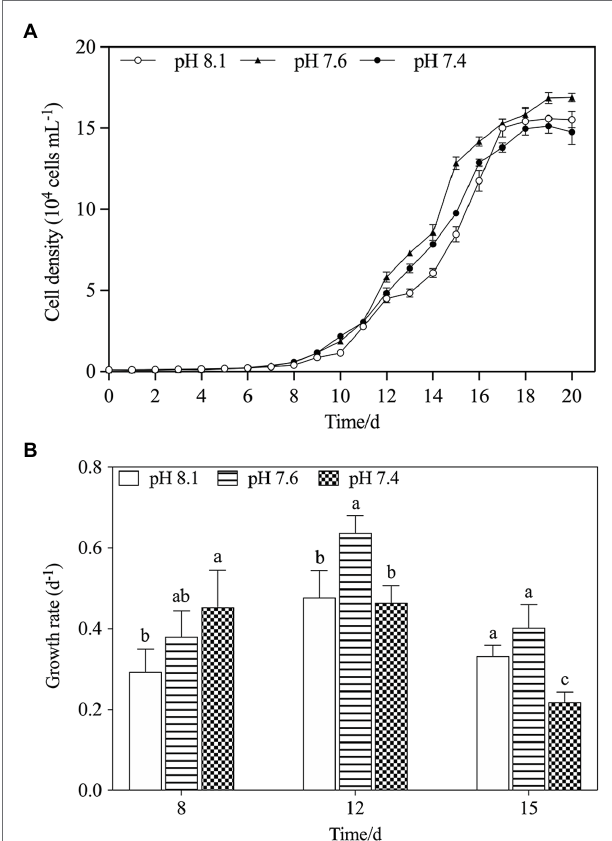
FIGURE 1 | The changes of population dynamics of K. mikimotoi when exposed to different pH levels. (A) Cell density; (B) Specific growth rate. Data are presented as means ± SD. Different lowercase letters indicate significant differences between the treatment and the control at each time point ( p <